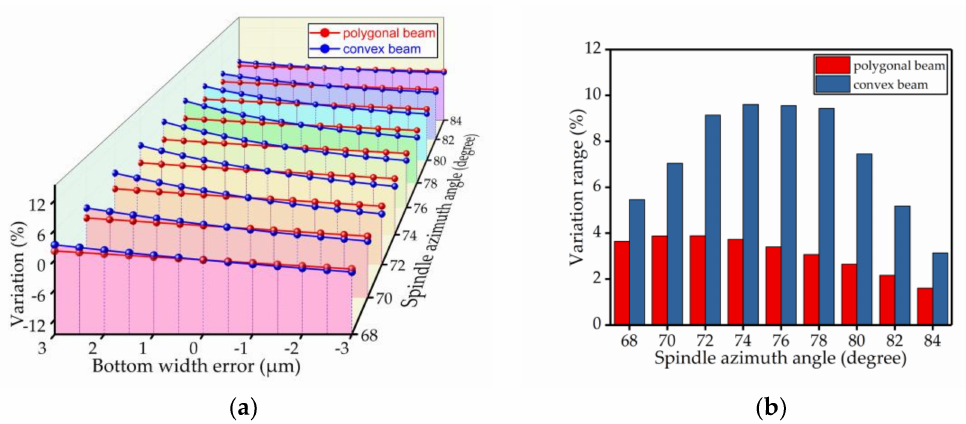
Figure 13. The influence of the bottom width error on the spindle azimuth angle of the polygonal cross-section beam and convex cross-section beam; ( a ) shows the relationship between spindle azimuth angle variation and bottom width error; ( b ) shows the range of variation—the value is the difference between the maximum and minimum values of each line.